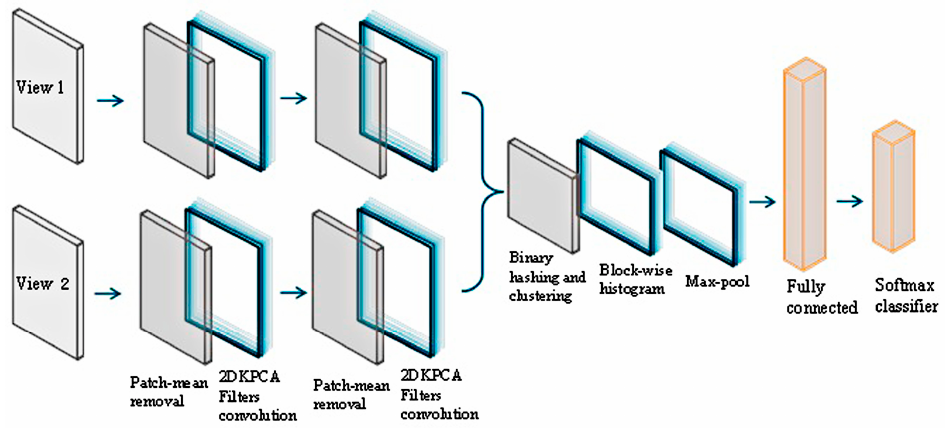
Figure 4. Two-view Figure 4. Two-view classifier.